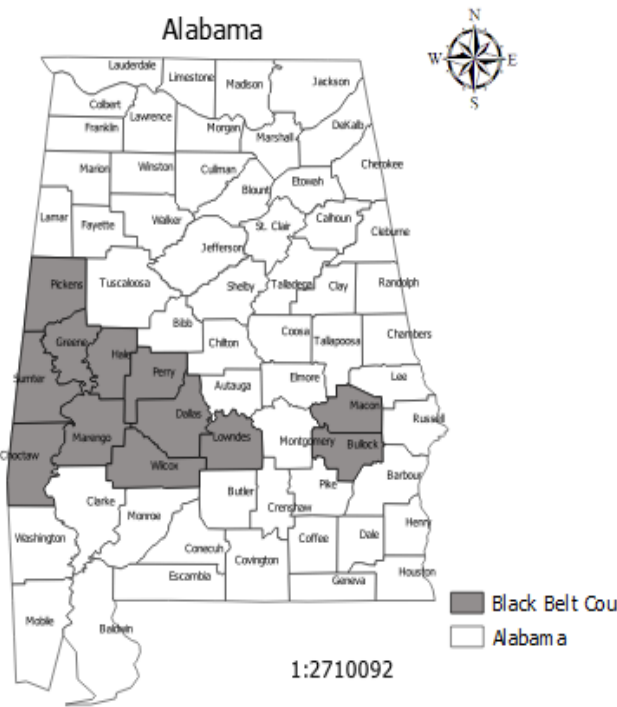
Figure 2. Map indicating the twelve counties which make-up Alabama’s Black Belt.